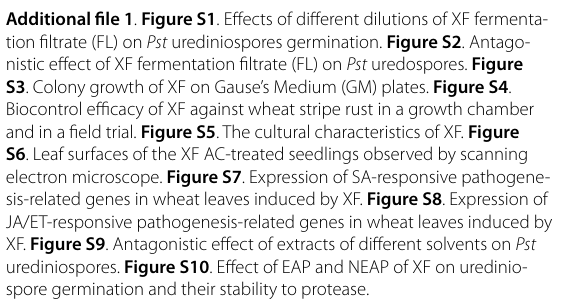
XF. Figure S9 . Antagonistic effect of extracts of different solvents on Pst urediniospores. Figure S10 . Effect of EAP and NEAP of XF on uredinio- spore germination and their stability to